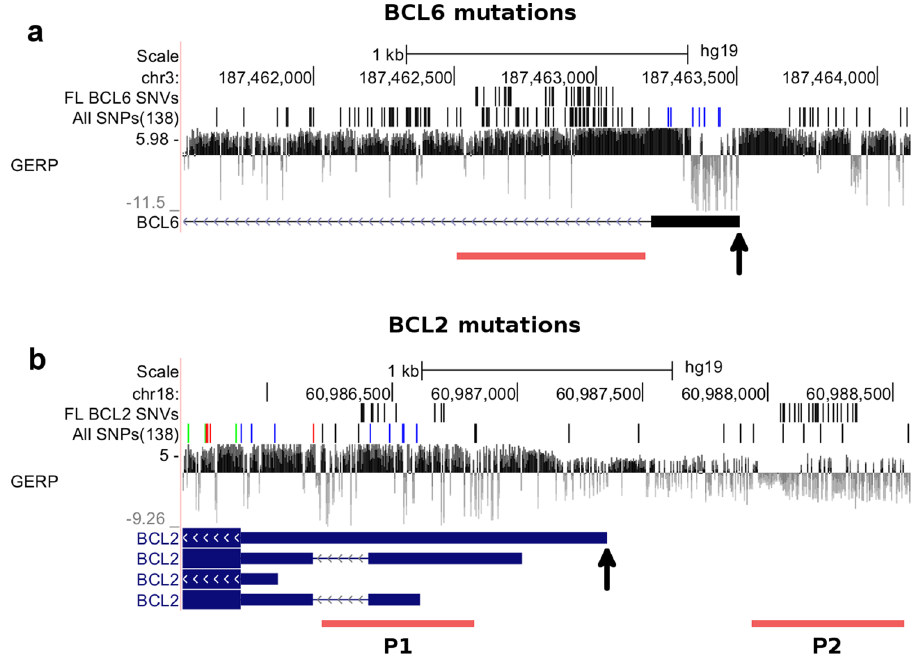
Figure 2. Predicted regulatory mutation blocks in BCL6 and BCL2 from a test cohort of 14 FL patients. Genome Browser overview of BCL6 and BCL2 mutation blocks. For reference, all mutations from dbSNP and GERP conservation scores are given. The reference genome annotations are displayed below, with solid bars representing exons and thin lines representing introns. Arrows on introns indicate direction of transcription. Black arrow marks the TSS. Red bars represent locations of the predicted regulatory mutation blocks of BCL6 and BCL2 . P1 and P2 represent BCL2 regulatory mutation blocks one and two,